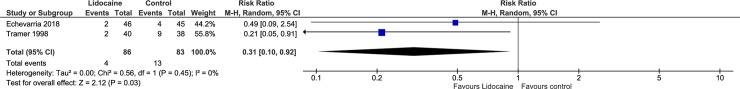
Forest plot of the incidence of need for antiemetic rescue medication.CI, confidence interval.